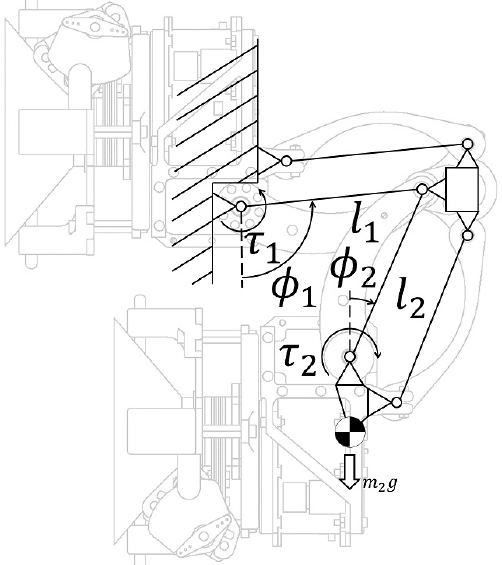
Figure 8. A schematic figure of the simplified model regarding the arm